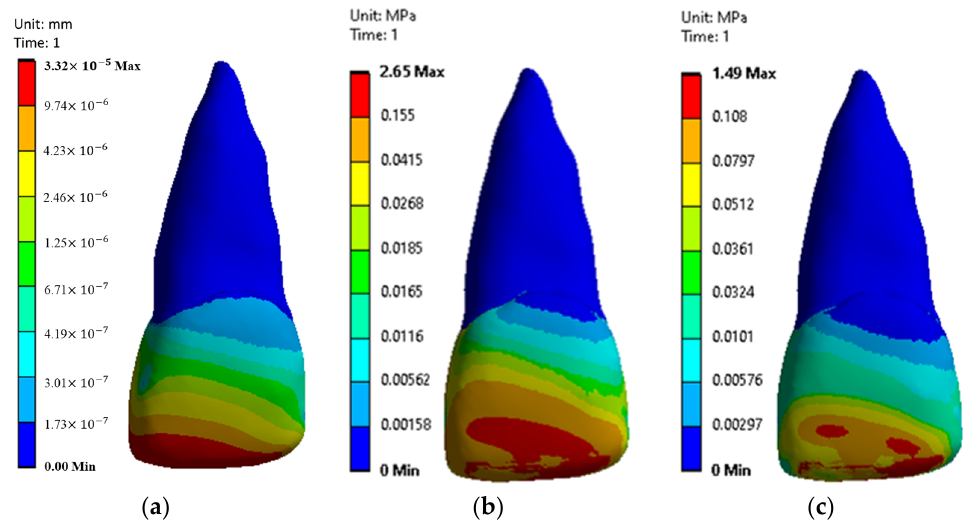
Figure 5. Contours under masticatory loading: ( a ) Displacement, ( b ) von Mises Stress, and ( c ) Shear Stress.